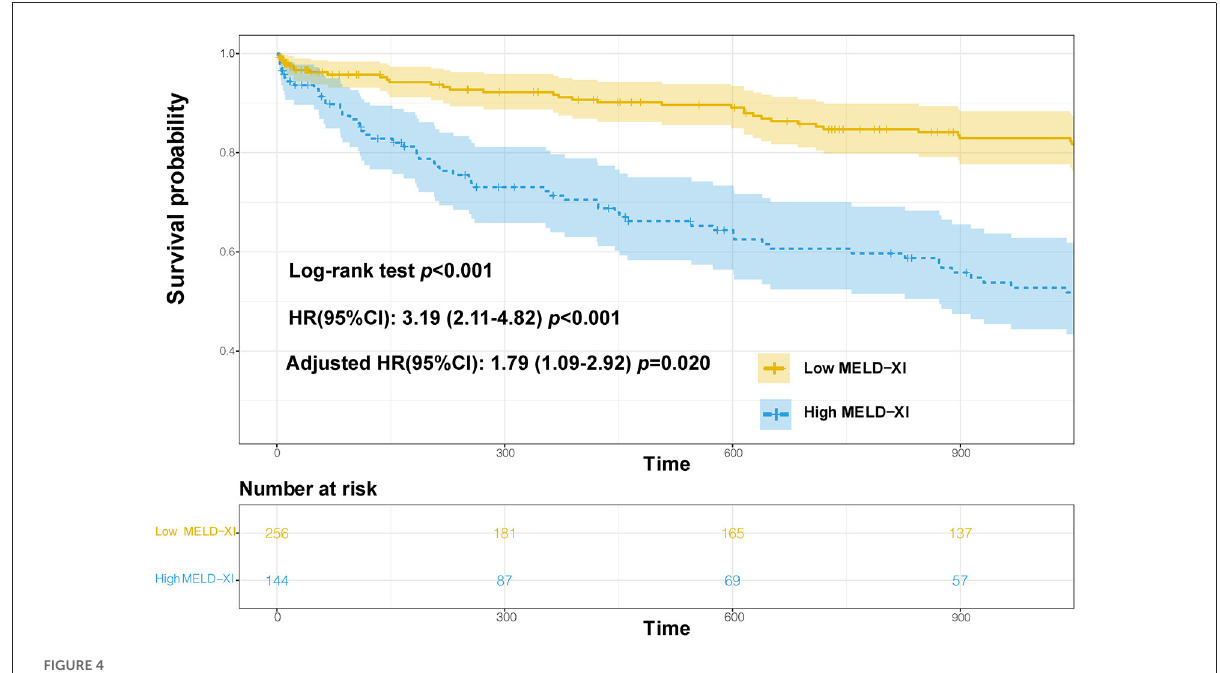
FIGURE4 Survival